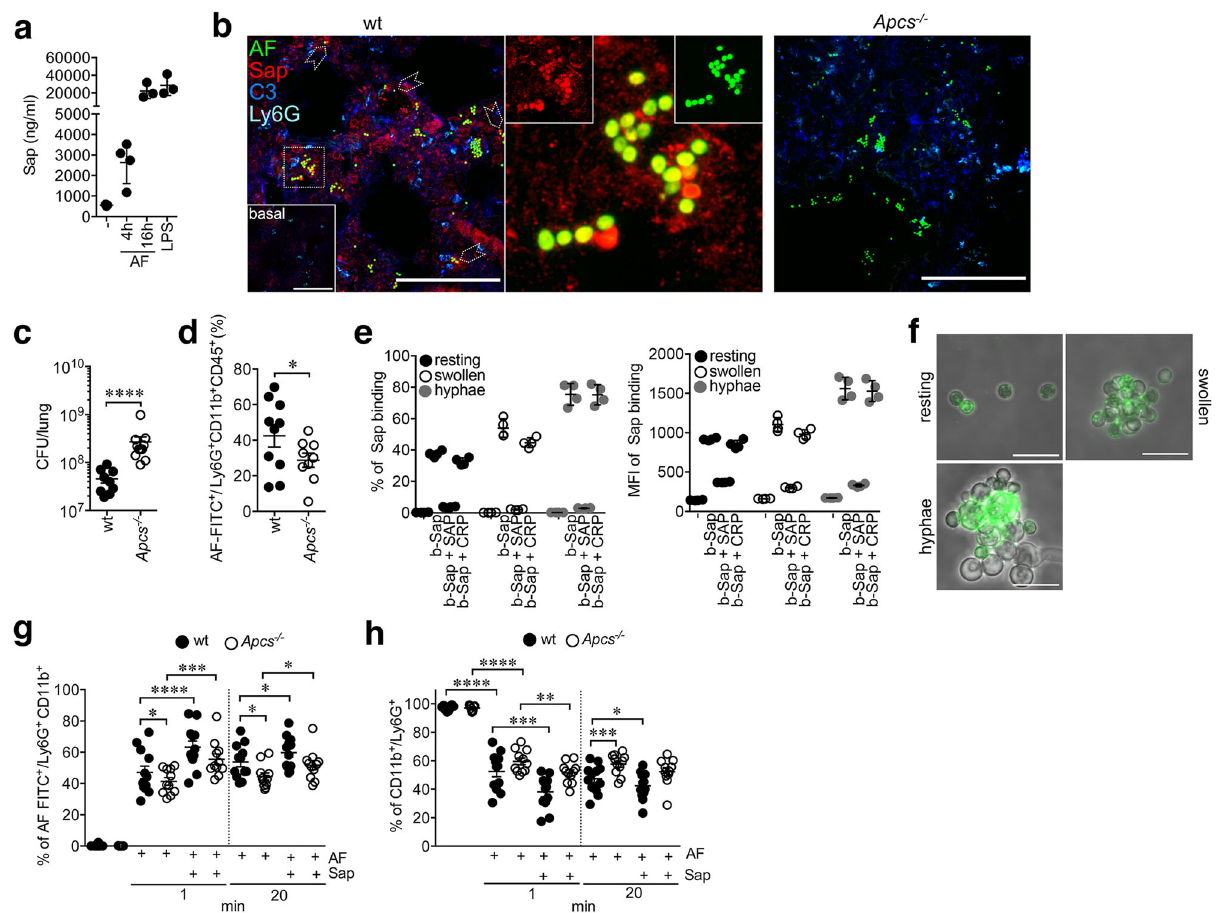
Fig. 2 SAP acts as opsonin for phagocytosis of A . fumigatus . a Induction of SAP levels in mice after i.t. injection of 5 × 10 7 AF conidia; − , sham mice; LPS, 0.8 mg/kg. Mean ± SD of an independent experiment; n = 3, − ; n = 4, AF 4 h; n = 3, AF 16 h; n = 3, LPS. b Confocal images depicting SAP localization in infected lung (4 h; 5 × 10 7 fl uorescein (FITC)-labeled AF conidia; n = 3 mice). Left, merged image of a lung stained for SAP (red), C3 (blue) and neutrophils (Ly6G + cells; cyan). Conidia are evident from the detection of FITC (green) signal. Dashed white arrowheads indicate regions of SAP localization on AF conidia. A representative staining of lung of a non-infected mouse is also shown (basal; left box). Middle, close-up image of the white dashed region (left) showing SAP localization on AF. The image refers to extracted AF and SAP signals also separately shown in the boxes within the image. Right, a section of infected lung of Apcs − / − mouse is also shown. Scale bar, 50 µ m. c Number of CFU per lung at 16 h after infection with 5 × 10 7 conidia. Each spot corresponds to a single mouse (wt, n = 9; Apcs − / − = 11). One experiment out of 2 performed with similar results. Mean ± SEM. P < 0.0001 (two-sided, Mann – Whitney U -test). d FACS analysis of in vivo phagocytosis in BALF neutrophils 4 h after injection of 5 × 10 7 FITC-labeled AF conidia. The fi gure shows results of two pooled experiments with n = 10 wt and n = 9 Apcs − / − mice. Mean ± SEM. * P = 0.05 (two-sided, unpaired t -test). e , f Interaction of SAP with A. fumigatus . e FACS analysis of binding of biotin-conjugated (b-) murine SAP (Sap; 10 µ g/ml) to viable dormant or germinating conidia of AF (1 × 10 8 ). Human SAP (50 µ g/ml) and CRP (50 µ g/ml) were also used. Mean± SD of one quadruplicate experiment of two performed. f b-Sap (10 µ g/ml) interaction with AF. Images refer to maximum intensity projection of z -stacks. Scale bar, 5 µ m. g , h Effect of SAP on A. fumigatus phagocytosis by neutrophils. g , h FACS analysis (one experiment shown out of 3 performed) of phagocytosis ( g ) and CD11b internalization ( h ) in neutrophils after challenge with FITC- labeled AF conidia (1 × 10 7 /200 µ l of blood) opsonized or not with murine SAP is shown. g neutrophil phagocytosis in whole blood of wt and Apcs − / − mice. h CD11b expression in neutrophils of g . g , h n = 12 wt and n = 11 Apcs − / − mice. Mean± SEM. g 1 min, * P = 0.05; *** P = 0.002; **** P < 0.0001. 20 min, * P = 0.01, wt vs. Apcs − / − ; * P = 0.03 wt vs. wt + Sap or Apcs − / − vs. Apcs − / − + Sap. h 1 min, * P = 0.01; *** P = 0.0004; **** P < 0.0001; 20 min, * P =